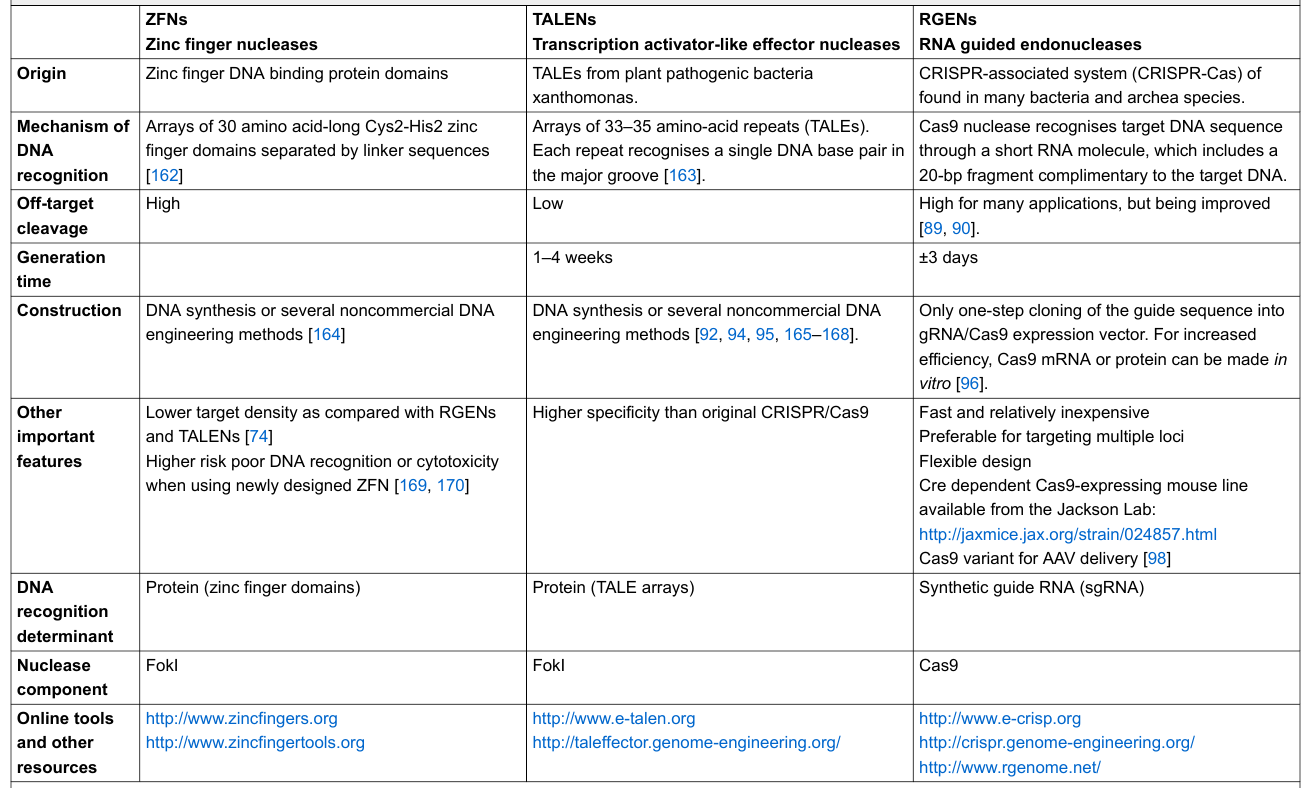
Zinc finger DNA binding protein domains